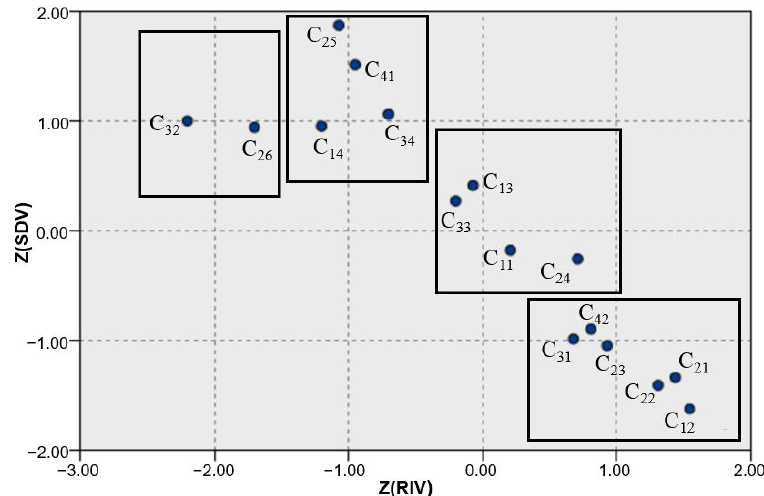
Figure 2. Grouping diagram of nearest neighbor elements.